Question: What form of chart is displayed?
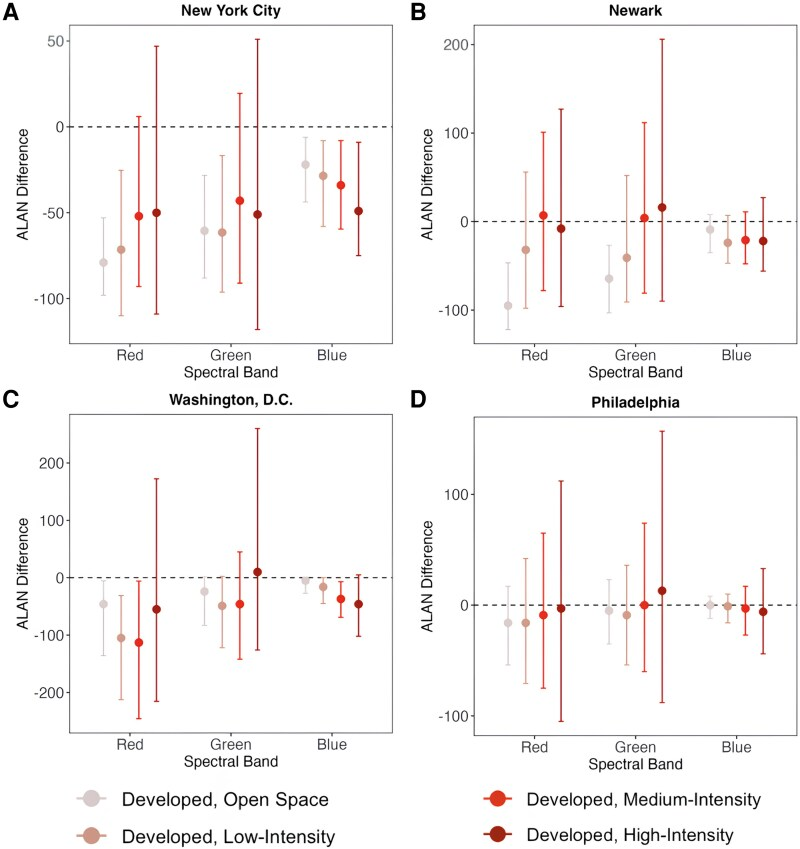
Answer: bar